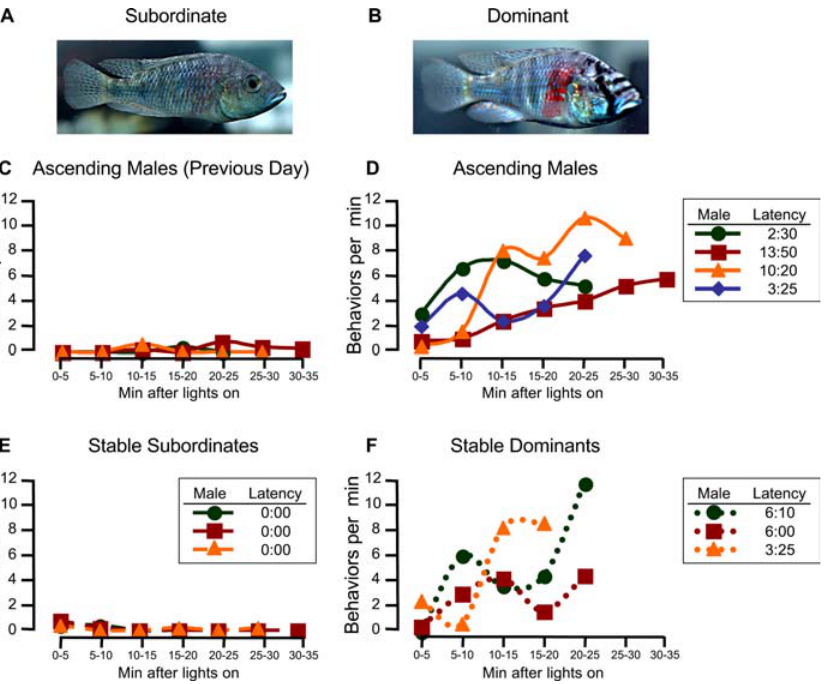
Figure 1. Time Course of Behavioral Response to Social Opportunity (A and B) Males displaying subordinate and dominant status. (C–F) Rate of dominance behaviors of individual ascending males the day before and during social opportunity, of stable subordinate males, and stable dominant males. Legends indicate latency (min:sec) to express dominance for each male on the day of sacrifice. Dominance behaviors are represented by composite scores consisting of the sum of chases, threat displays, courtship solicitations, and twice the number of spawning-site entries produced per minute. DOI: